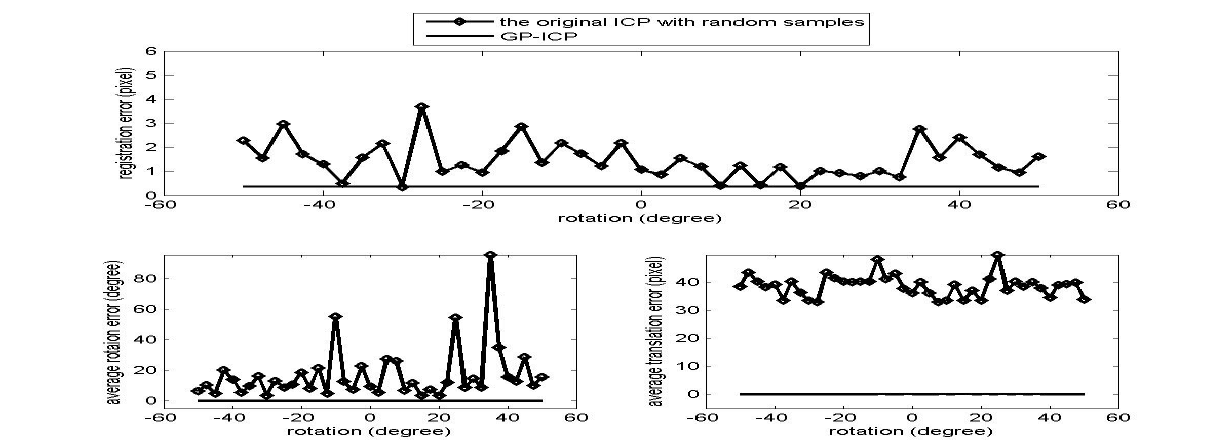
Figure 5. Convergence region test of the point clouds from the golf club with a translation, the translation 2, i.e. (H/4, L/4,